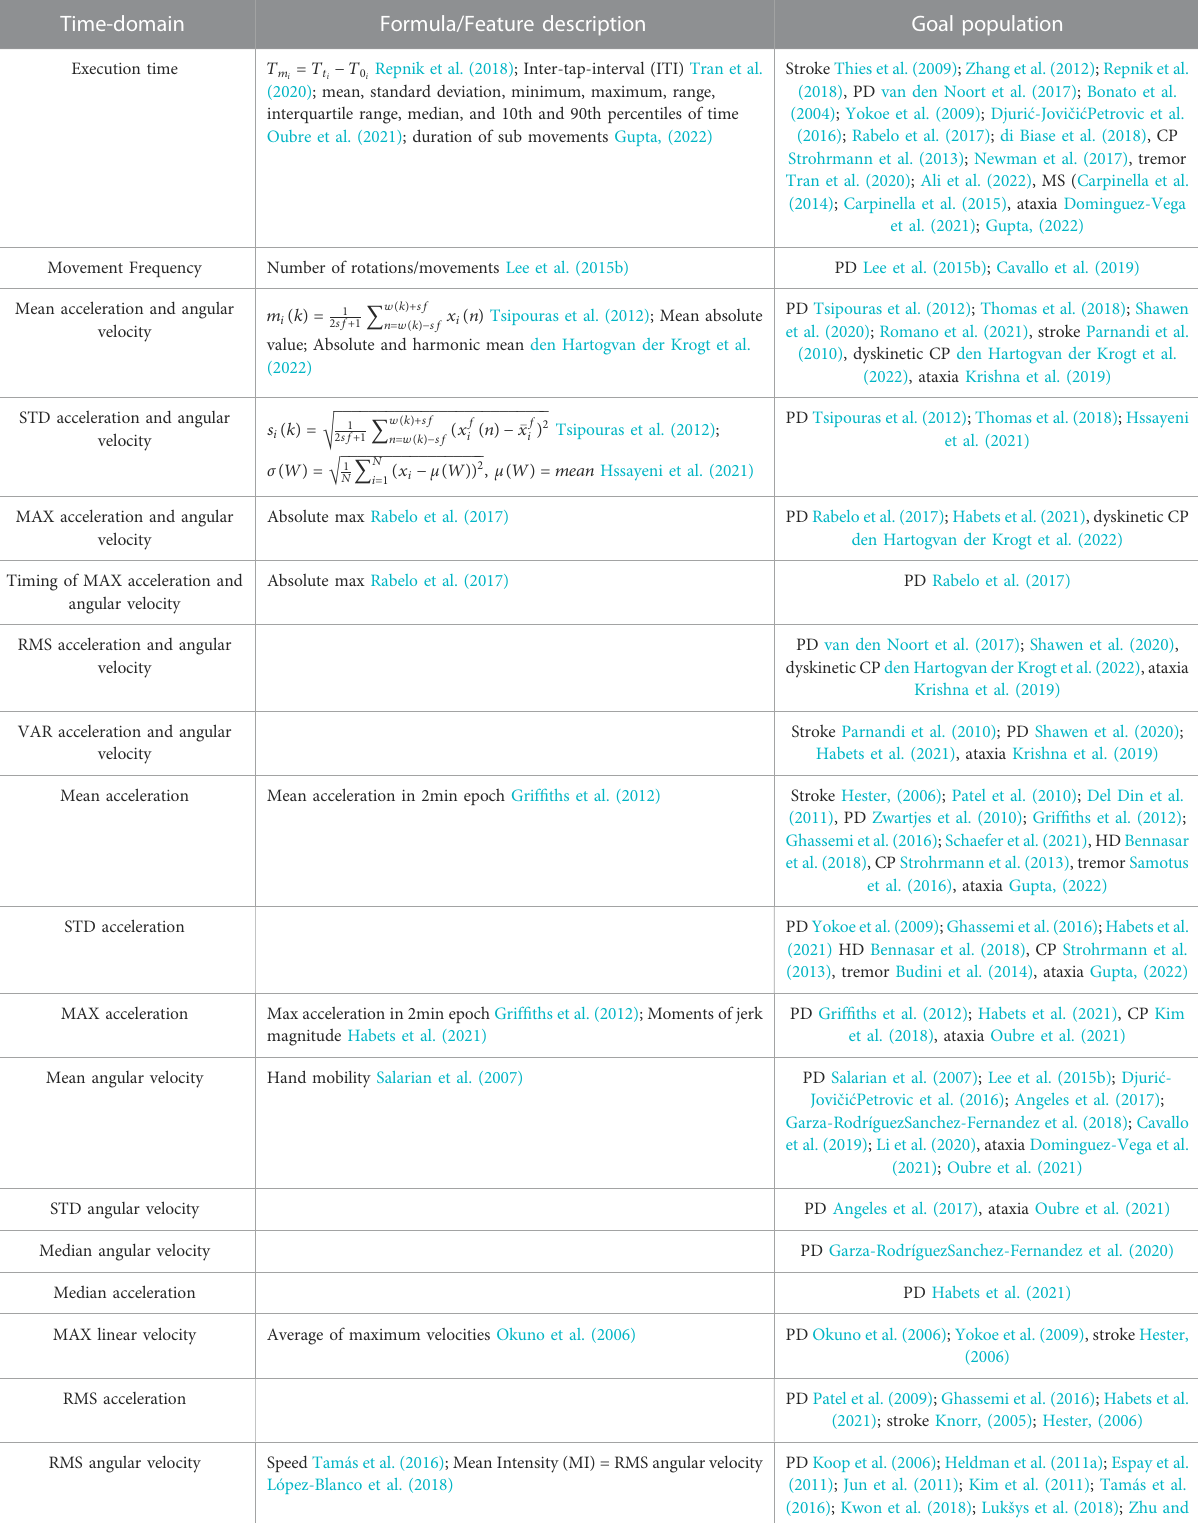
TABLE2Calculated sensorfeaturesintimeandfrequency-domain.STD=standarddeviation;max=maximal;RMS=root-mean-square;VAR=variance;IQR= inter-quartile range. PSD = power spectral